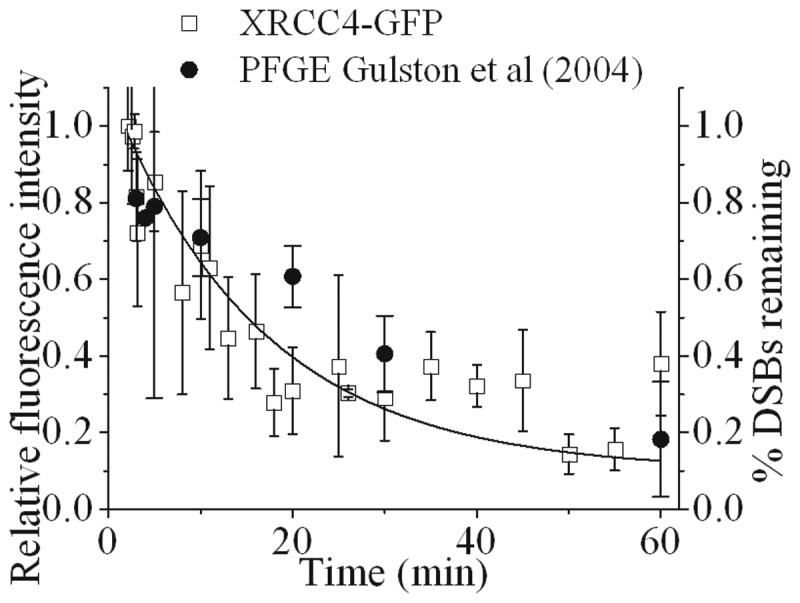
Time course of the repair of DSBs visualized by real-time recruitment and loss of fluorescence intensity of XRCC4-GFP following NIR microbeam irradiation with 730 nm photons (at a power of 10 mW through a ×60 objective) in cycling XRCC4-GFP tagged XR1 cells and PFGE data taken from Gulston et al. (56). The kinetic analysis to obtain the best fit to the experimental data are shown as solid lines and described in the Materials and Methods section.